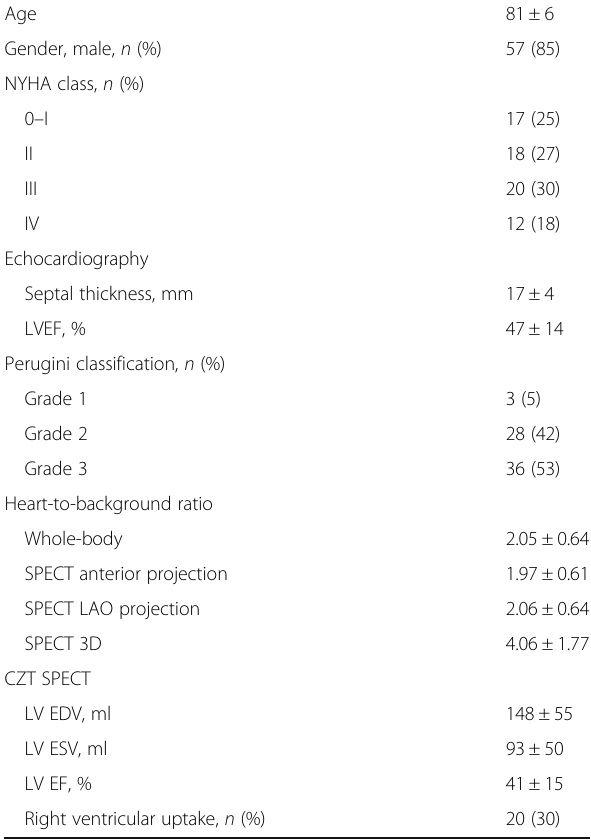
Table 1 Patients characteristics